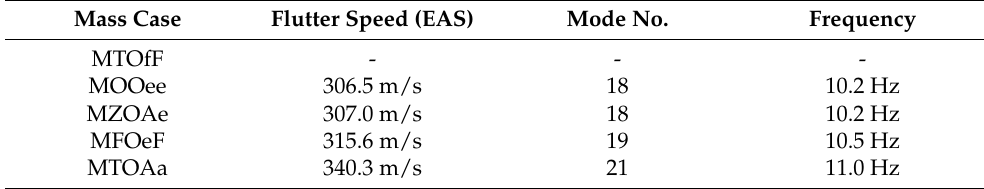
Figure 14. Influence of the payload/fuel combinations on the critical flutter characteristic for the baseline. Table 5. Flutter results for the different mass cases of the baseline configuration at 0% damping.